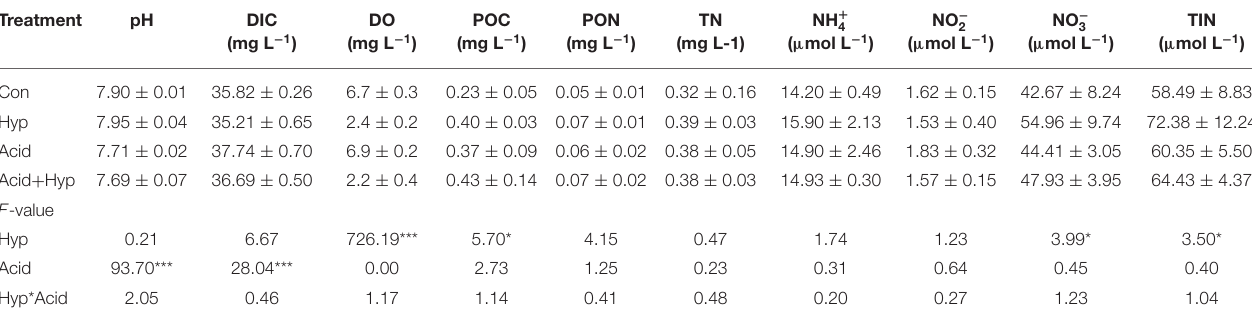
TABLE 2B | Effects of ocean acidification and hypoxia on water chemical properties at the Hongxing wharf.